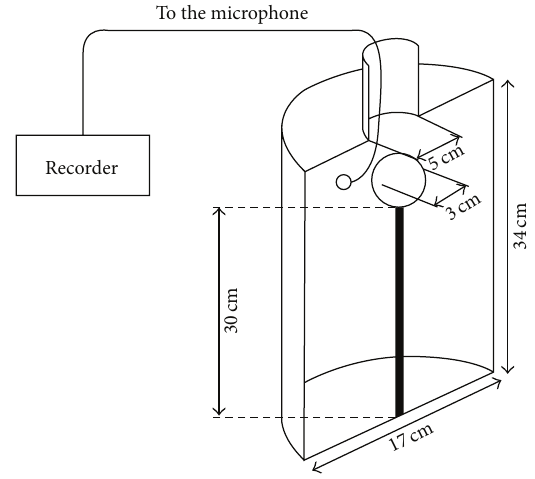
Figure 6: Schematic cross section view of the setup for ping pong ball below the neck of a Helmholtz resonator.